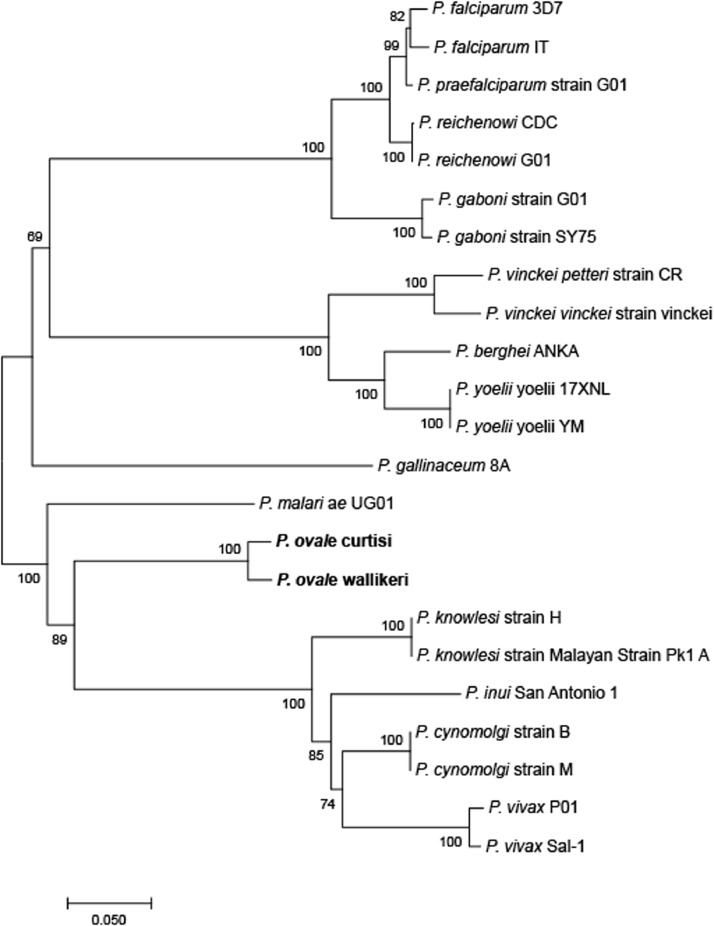
Phylogenetic relationship of ama1 genes within ortholog Plasmodium species by using NJ method.